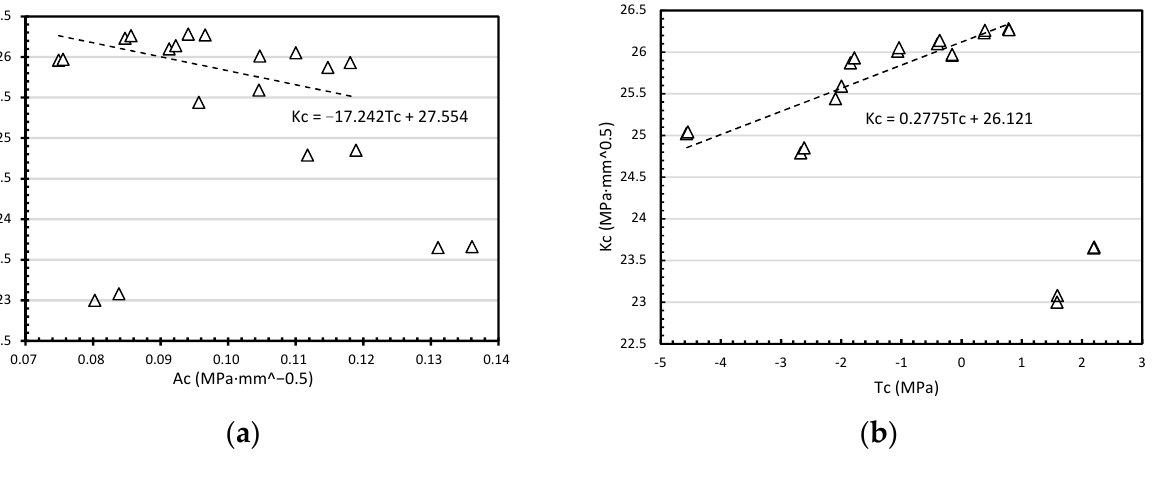
Figure 4. Scatter plot of K c : ( a ) with A c with ( b ) T c . Equations (9) and (12) are derived in the case where the crack is split along the crack tip extension line, therefore, this equation cannot be established when the crack initiation angle is not 0 ◦ . In the experimental data in Table 1, when F x = 2.01 kN and 2.54 kN (NO. 7 and 8), the crack starts to curve from the crack initiation point, so it does not meet the condition of Equation (9) and should be eliminated when fitting the curve. The specimens of these two tests are shown in Figure 5. The photo shows that the crack begins to bend only at the crack initiation point on one side, while the other crack begins to bend after extending a certain distance in the horizontal direction. Theoretically, the crack should expand in both directions in the same way if the specimen and load are completely symmetrical. However, such a situation is too idealistic, and the difference in load and crack length causes the crack on one side to expand first, which causes the load to drop at this moment, and the crack on the other side to expand along a straight line. In this paper, we ignore this effect and assume that if the crack on either side begins to bend at the crack initiation point, it means that the cracks on both sides are in a stress state where bending will Figure 5. Specimens bent from the crack initiation point.